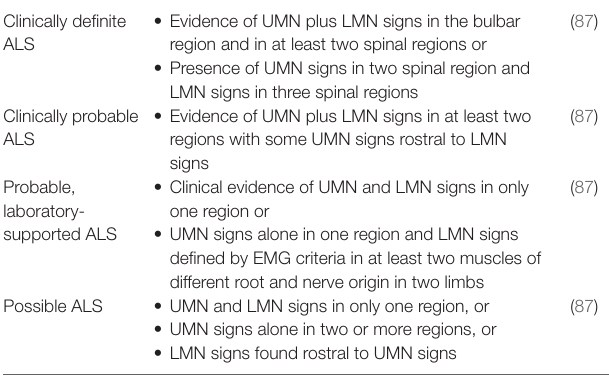
Clinically definite